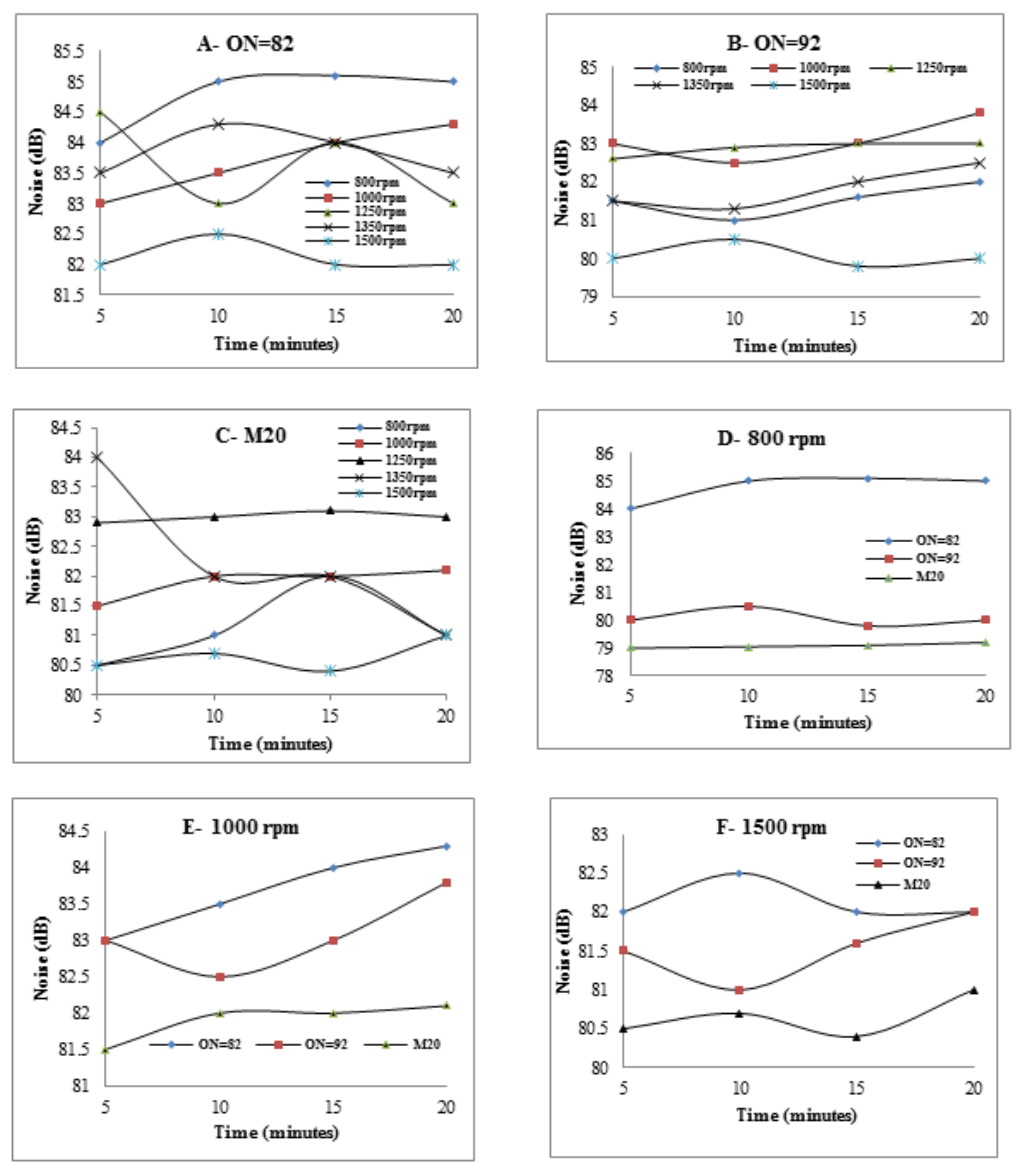
Fig. 8. The idling time effect on emitted Noise for tested fuels at variable engines speeds